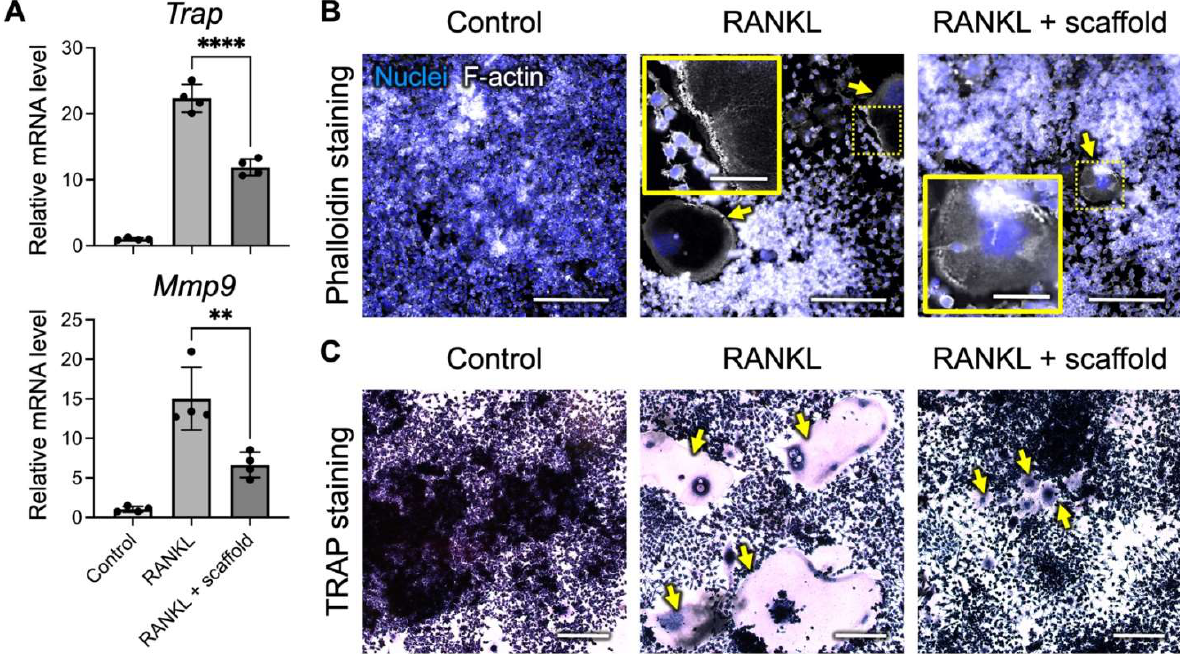
Figure 4. SrO 2 + MnO 2 @PLGA/gelatin scaffolds inhibit osteoclast differentiation. ( A ) Expression levels of the osteoclast-specific genes Trap and Mmp9 in the RAW 264.7 cells with or without receptor activator of nuclear factor κB ligand (RANKL) and scaffold treatment determined by quantitative PCR ( n = 4). ** p < 0.01; **** p < 0.001. Data are the mean ± s.d. ( B ) Representative fluorescence images of F-actin staining and (C) TRAP staining of RAW 264.7 cells after receiving various treatments. Yellow arrows indicate the ( B ) actin ring or ( C ) TRAP-positive cells. The yellow boxes show the regions outlined by dotted lines with higher magnification. Scale bars, 200 µm. Scale bars in insert, 50 µm.